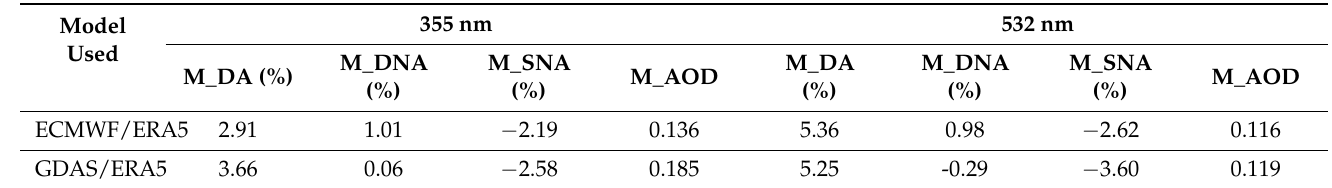
Table 5. Same as Table 4, but for two different forecast models compared with the corresponding reanalysis model.